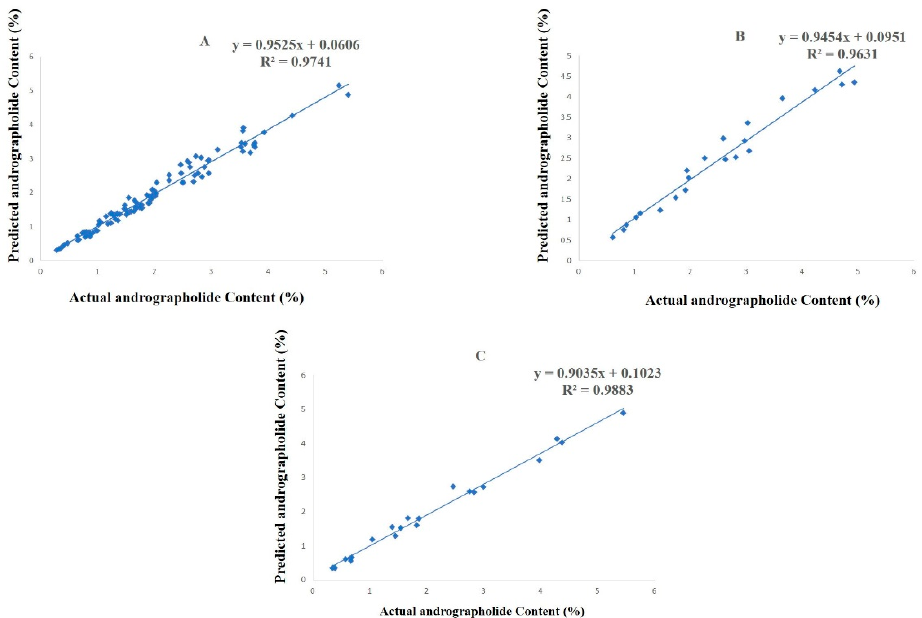
Figure 3. Scatter showing experimental and predicted values of andrographolide in training ( A ), testing ( B ), and validation ( C